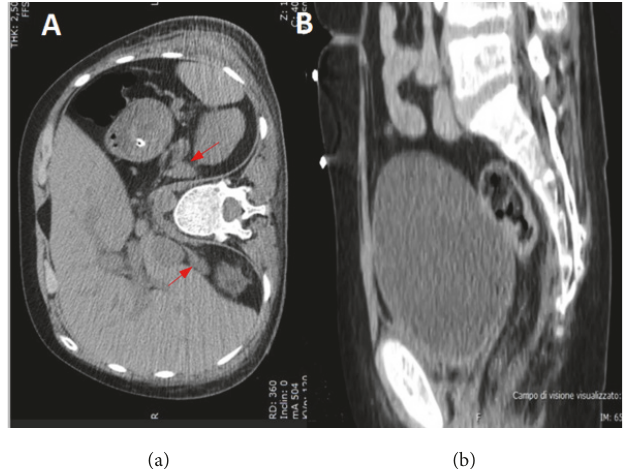
Figure 1: Abdomen and pelvis CT scan. (a) The adrenal glands are enlarged bilaterally (red arrow); (b) gonads are not